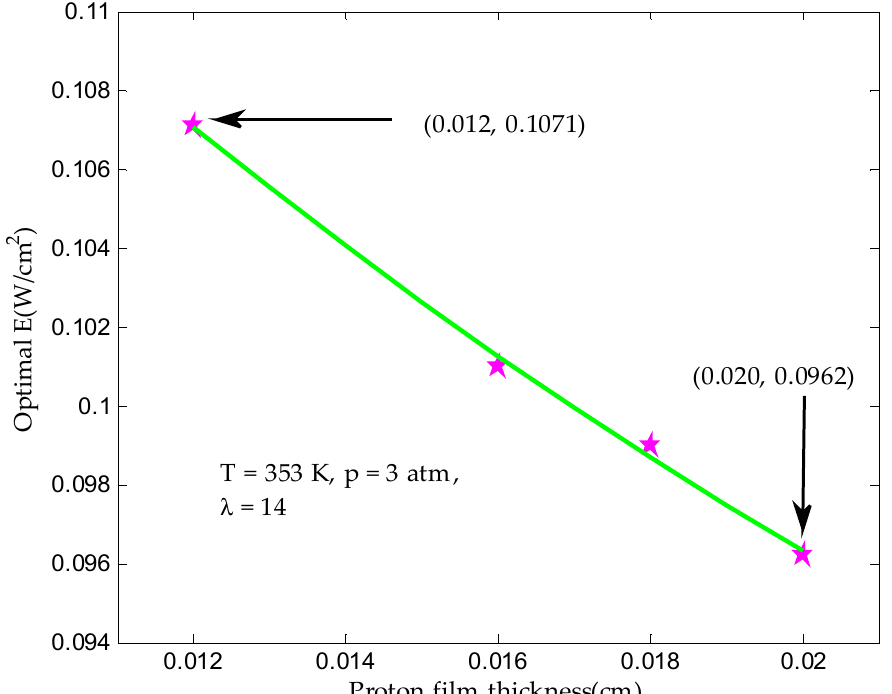
Figure 13. Optimal ecological objective function varying with membrane thickness.